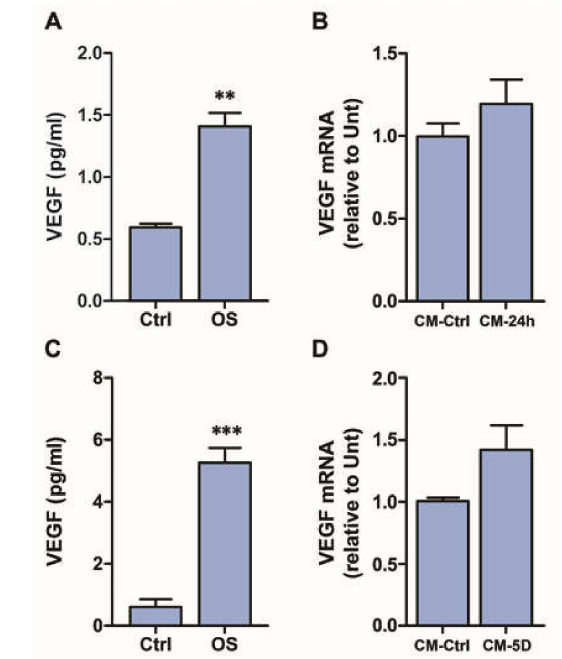
Figure 4. ( A ) VEGF release in the culture medium of retinal explants exposed to OS for 24 h, as measured with ELISA. ( B ) VEGF mRNA expression in retinal explants incubated for 24 h in non-conditioned medium (Ctrl) or in explants incubated for 24 h in the conditioned medium of explants exposed to OS for 24 h (CM-24h). ( C ) VEGF release in the culture medium of retinal explants exposed to OS for 5 days, as measured with ELISA. ( D ) VEGF mRNA expression in retinal explants incubated for 24 h in the conditioned medium of untreated explants (CM-Ctrl) or in explants incubated for 24 h in the conditioned medium of explants exposed to OS for 5 days (CM-5D). ** p < 0.01 and *** p < 0.001 relative to Ctrl. n = 3 in all